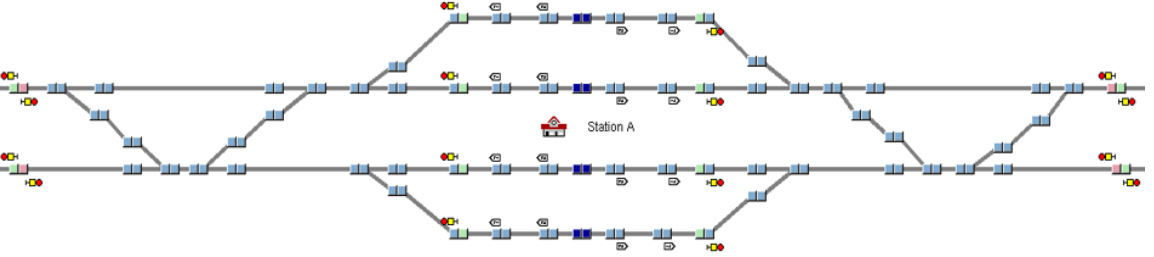
Figure 1: Model Station